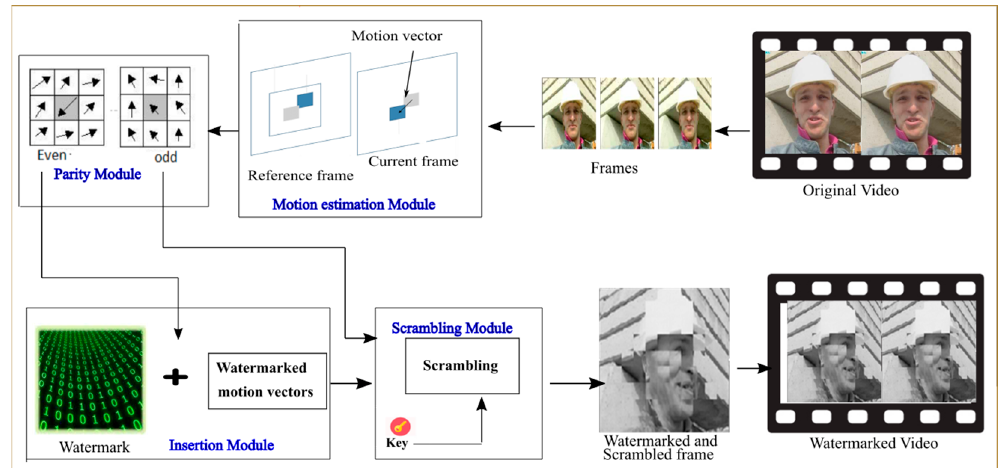
Figure 6. Overview of the watermarking application.